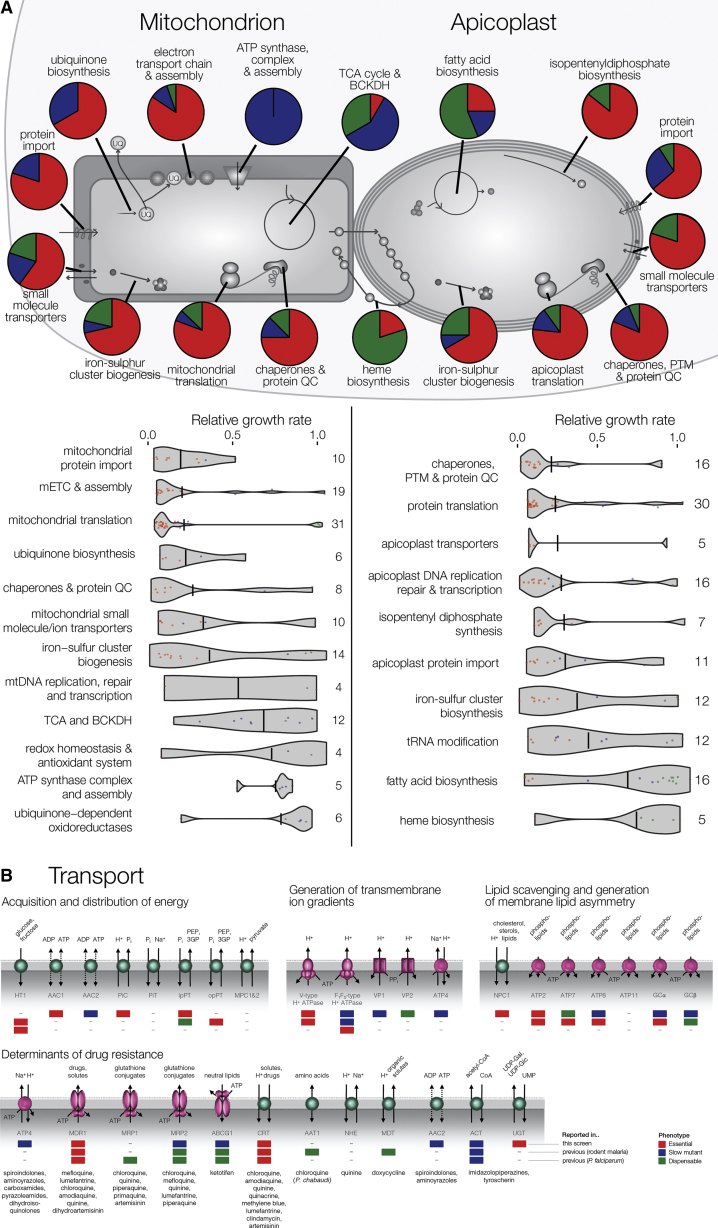
Knockout Phenotypes of Selected Organellar Pathways and Transport Functions(A) RGR and phenotype distribution of putative mitochondrial and apicoplast genes. See Table S3 for genes in each category. Violin plots show growth rate distributions with the horizontal line indicating the median. Number of genes per category is stated.(B) Knockout phenotypes of selected Plasmodium transporters. Dispensable, slow, and essential phenotypes are indicated by the green, blue, and red boxes, respectively. The phenotypes are from this study (top box) and from published P. berghei (middle box) and P. falciparum (bottom box) studies. Pumps (i.e., primary active transporters) are shown in pink and carriers (i.e., uniporters, symporters, and antiporters) in aqua. Examples of the antimalarial drugs affected by the resistance determinants are listed below each transporter.See also Figure S4 and Tables S7 and S8.